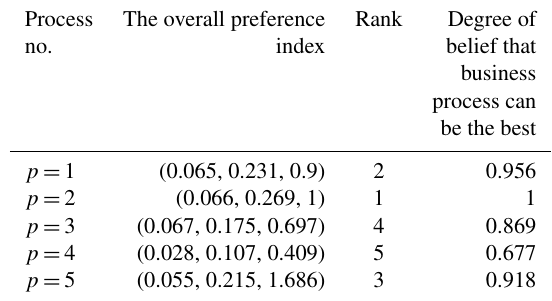
Table 5. Preference indices of business processes and their rank under environmental protection performance.